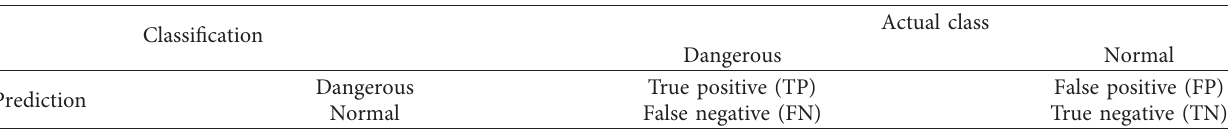
Figure 5: Study area (Sinseondae Pier, Busan Port Terminal). Table 2: Confusion